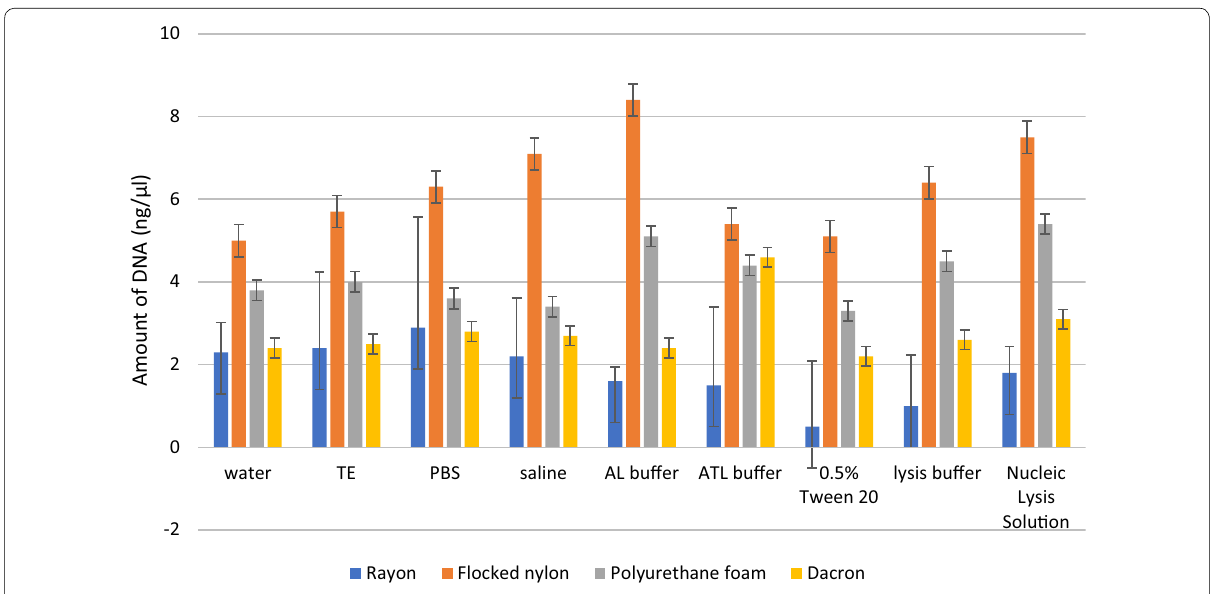
Fig. 4 DNA recovery using various washing out buffers and various types of swabs